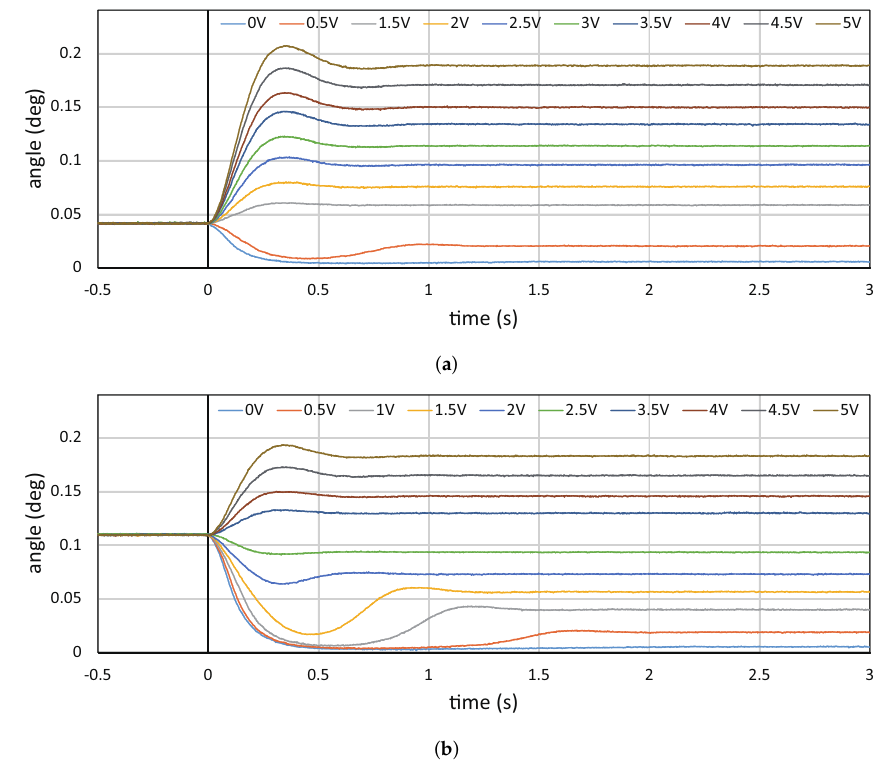
Figure 11. Step response of vibration amplitude: ( a ) 1 V; ( b ) 3 V.